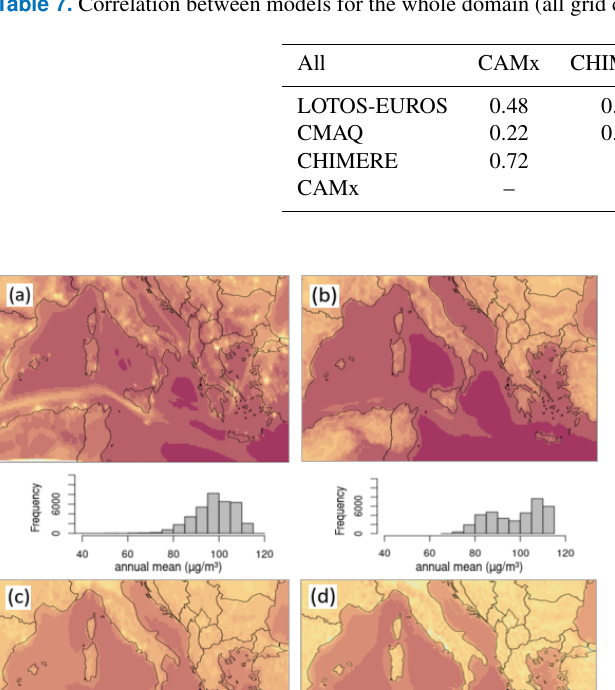
Table 7. Correlation between models for the whole domain (all grid cells) based on daily data for NO 2 total dry deposition.